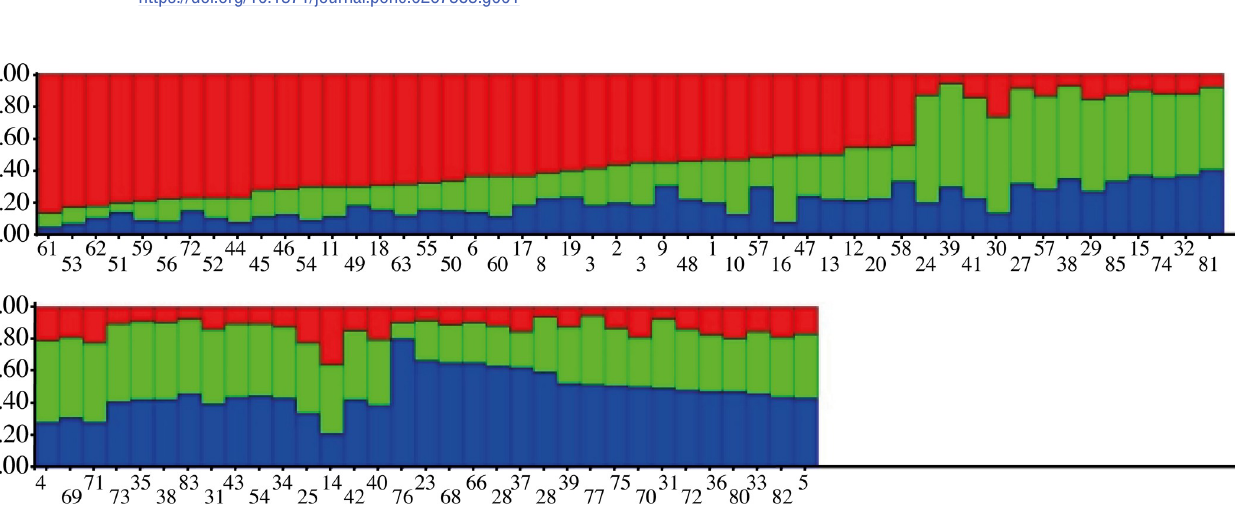
PLOS ONE | https://doi.org/10.1371/journal.pone.0267383 May 19, 2022 5 /